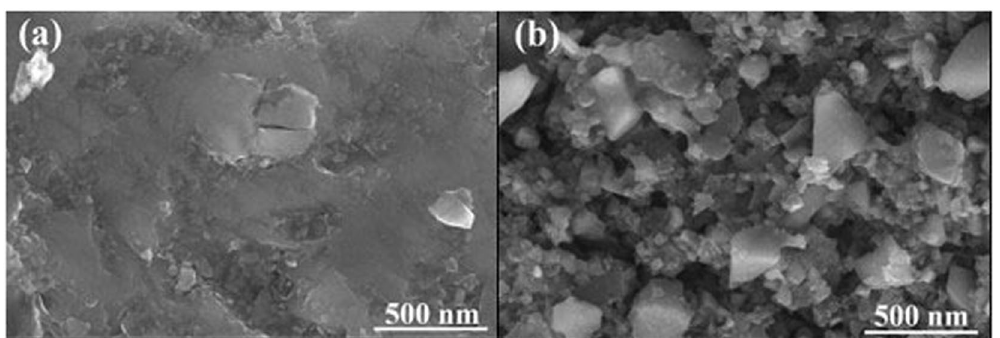
Figure 4. SEM of the shale surface: ( a ) untreated rock, ( b )